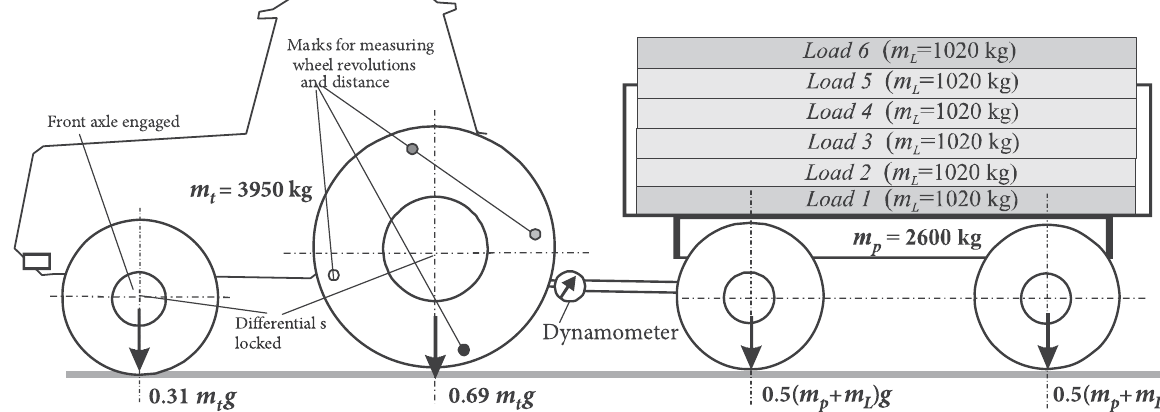
Fig. 1. The scheme of the load and measurement of an experimental tractor – trailer